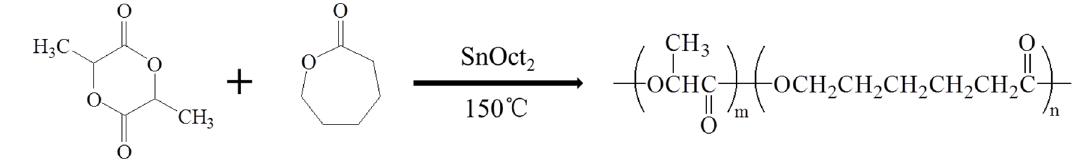
Figure 1. The synthesis procedure of poly(l-lactide-co-ε-caprolactone) (PLCL) copolymer.